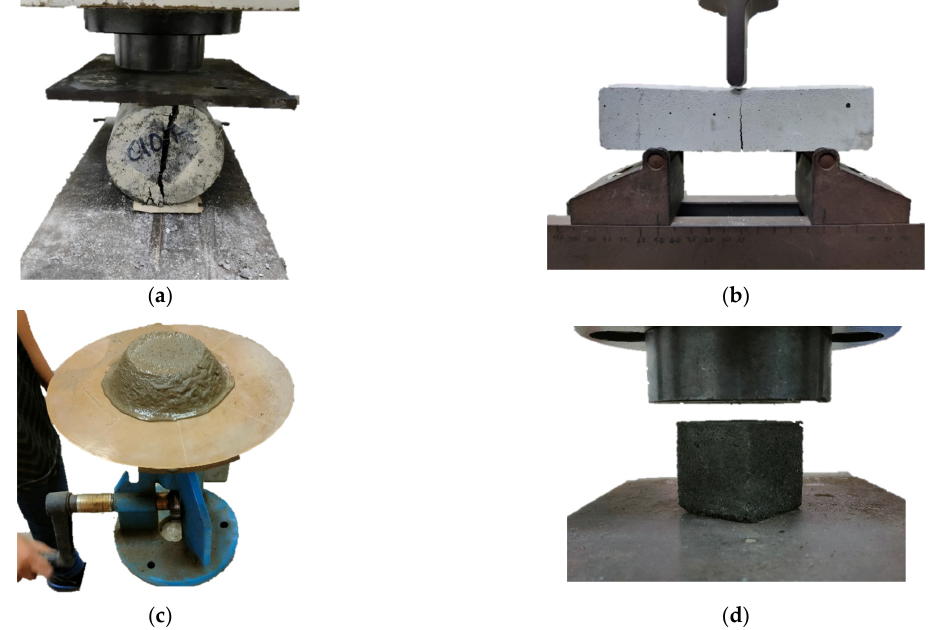
Figure 3. Test setup for experimental testing. ( a ) Indirect tensile strength test. ( b ) Flexural strength test. ( c ) Flowability test. ( d ) Compressive strength test.